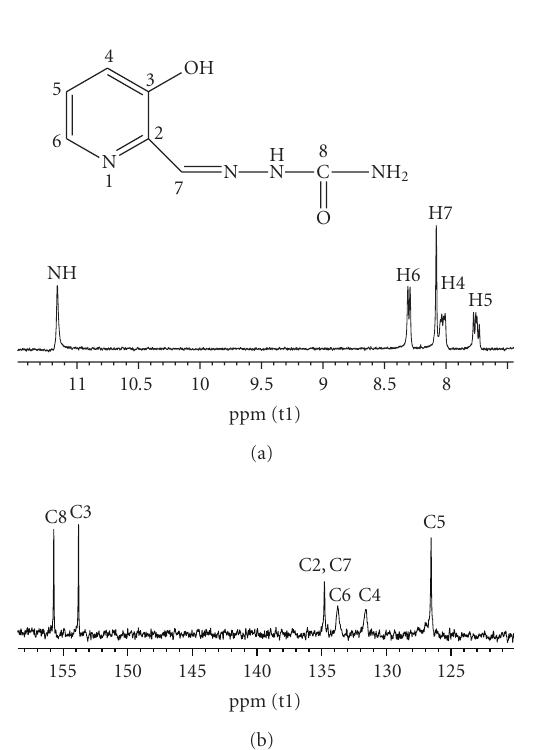
Figure 3: 1 H NMR (a) and 13 C NMR (b) spectrum of the ligand ( 1 ).